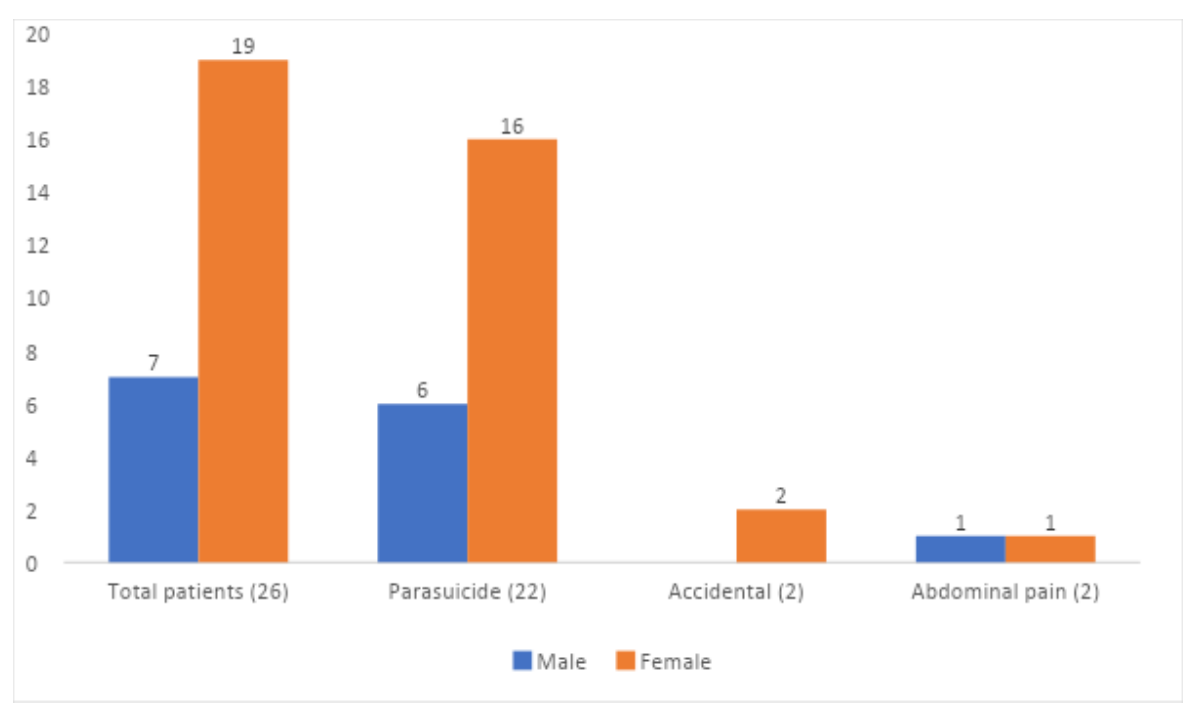
Figure 1. Reason for KMnO 4 Ingestion.